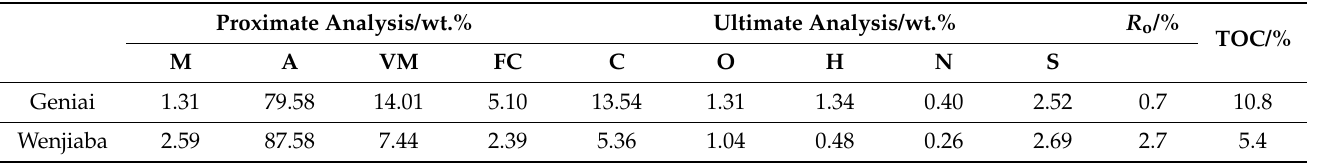
Table 1. Geochemical properties of the shale samples [38].